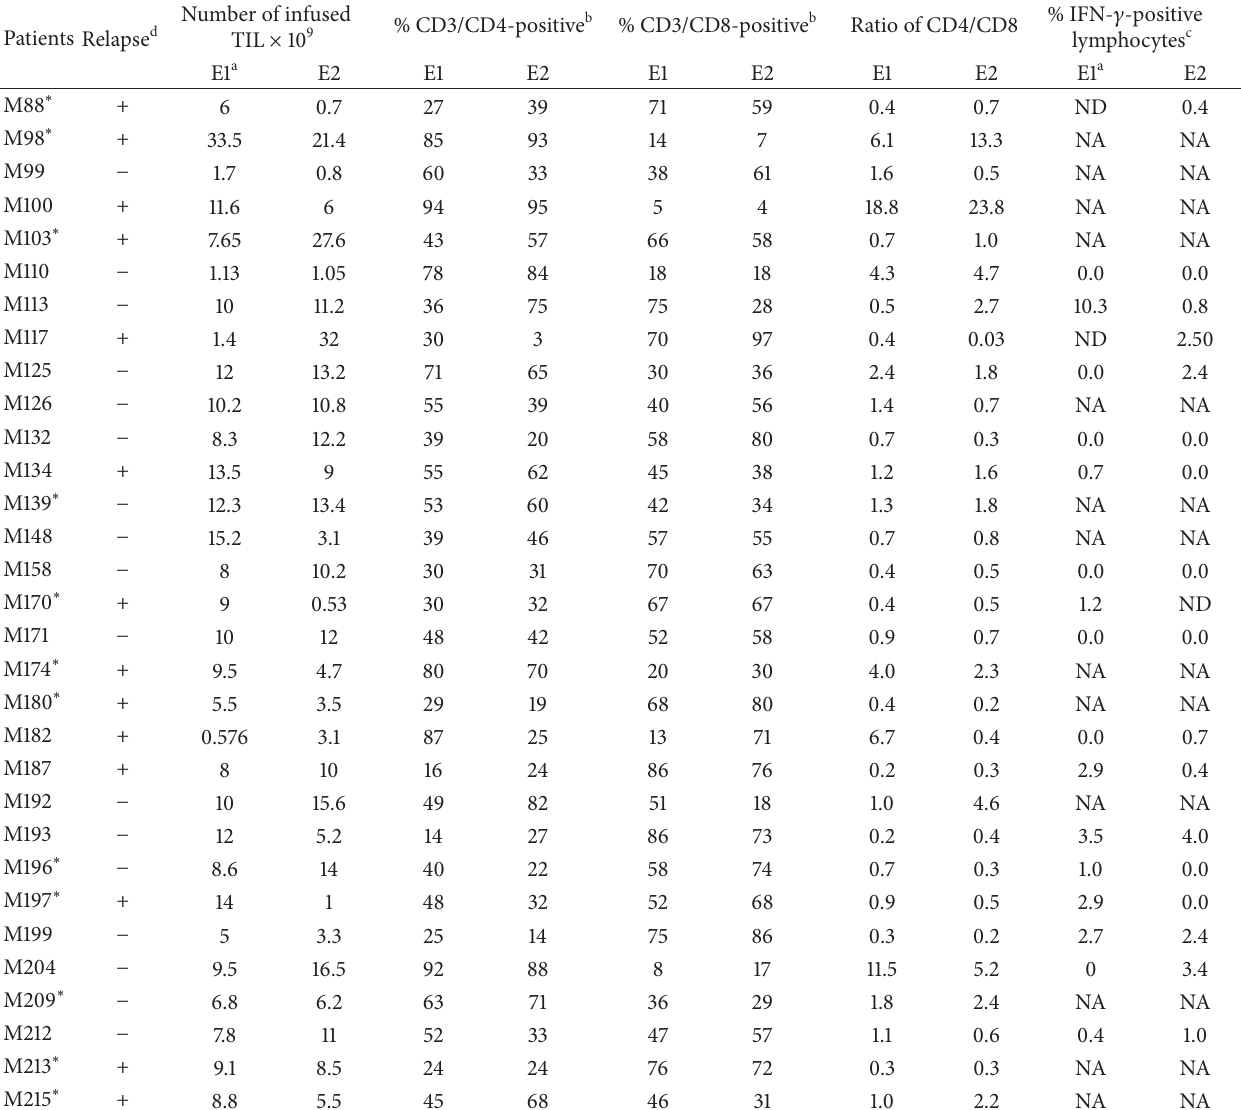
∗ Melanoma patients bearing only one metastatic lymph node. a